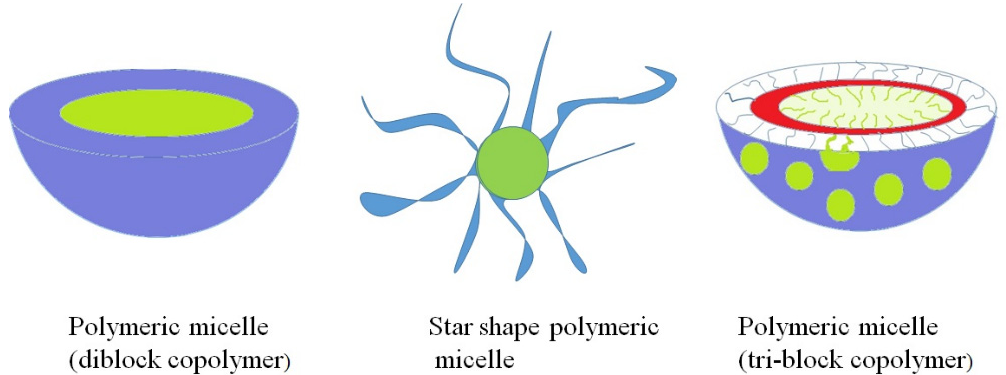
Figure 6. Examples of nanoparticle structures developed for PDT treatments.